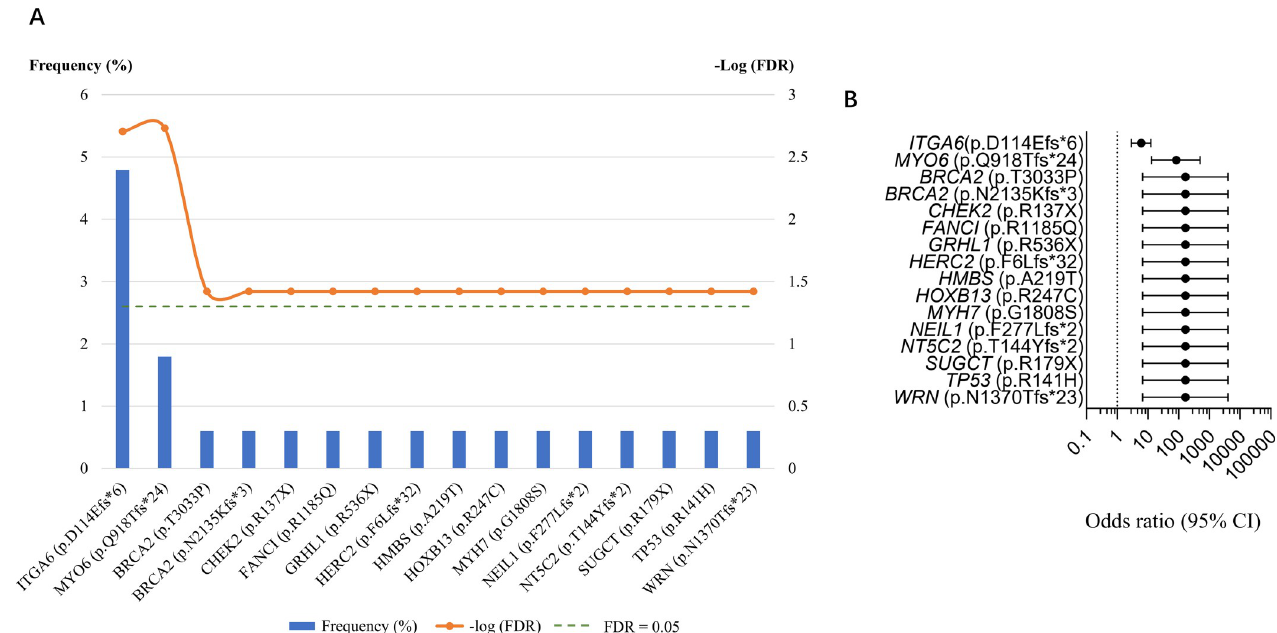
Fig 6. Comparison of the Shanghai cohort and East Asian individuals in the GnomAD. (A) Deleterious germline mutations significantly enriched (False Discovery Rate (FDR) � 0.05) in the Shanghai cohort compared with the 9,197 individuals from the GnomAD v2.1.1. (B) Odds ratio of deleterious germline mutations significantly enriched in the Shanghai cohort compared with the East Asian